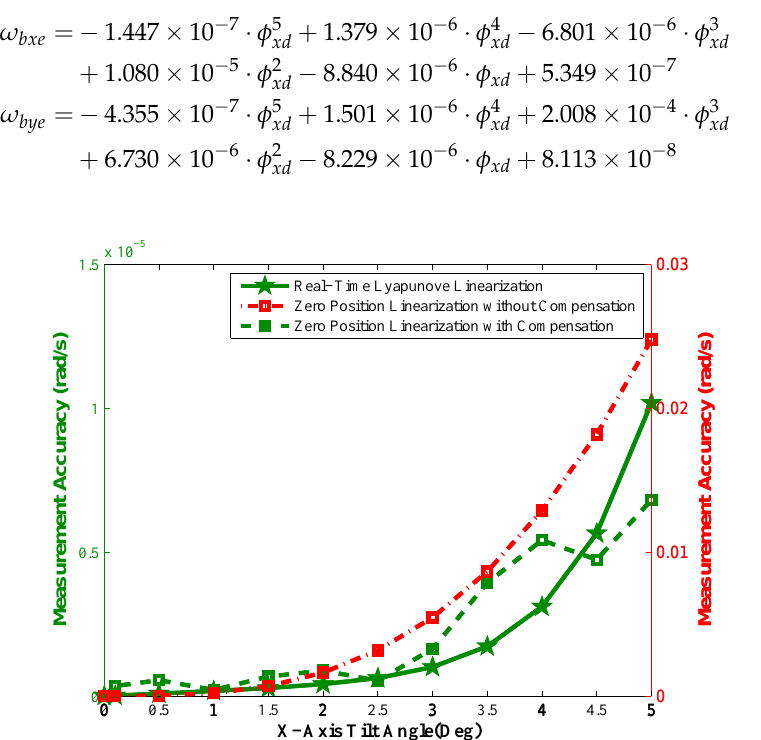
Figure 5. The change of measurement accuracy with the tilt angle.